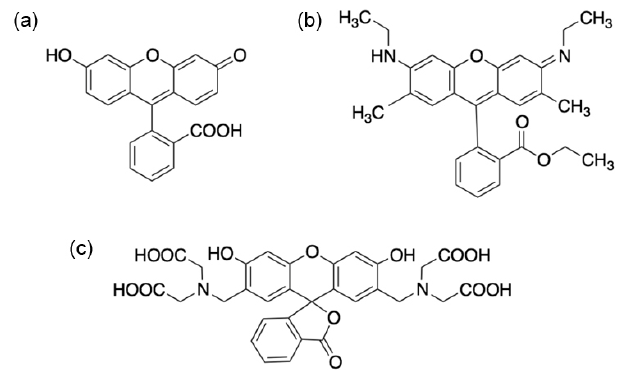
Figure 1. Molecular structures (neutral forms) of the three fluores- cent organic dyes used in this work: fluorescein, rhodamine 6G and